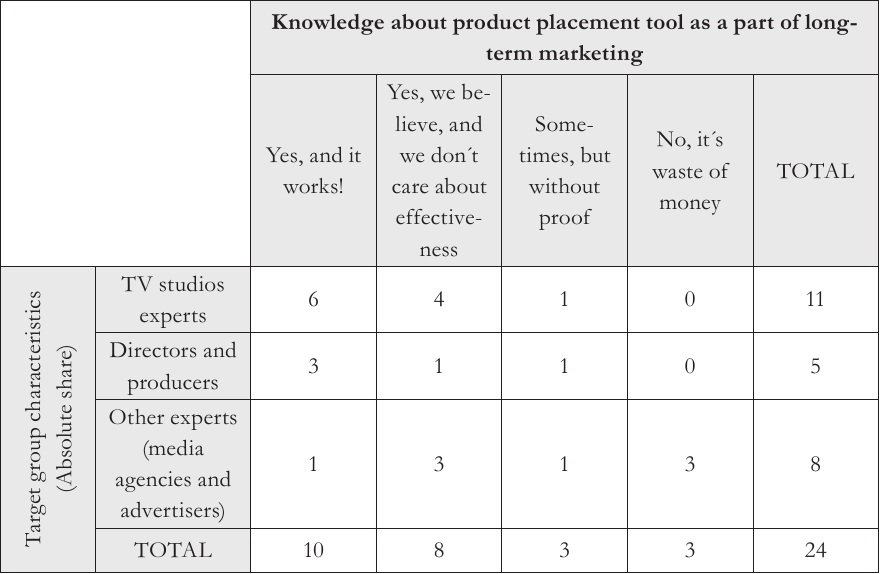
Tab. 3 – Dependence of knowledge about product placement tool as a part of long-term market- ing on the occupational structure of respondents. Source: